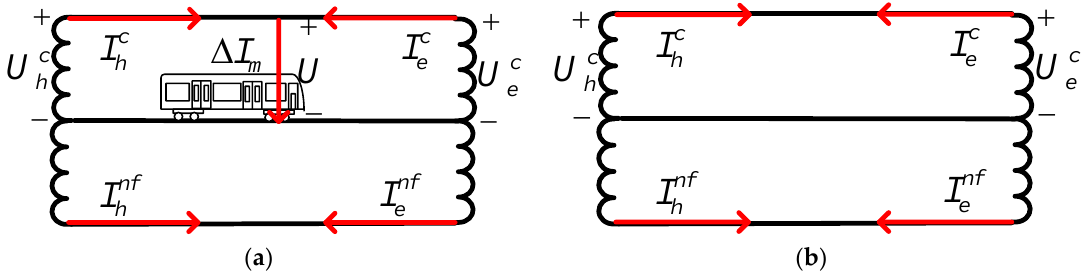
Figure 5. Current distribution at the AT subsections: ( a ) At the EMU running subsection and ( b ) at the no EMU running subsection.